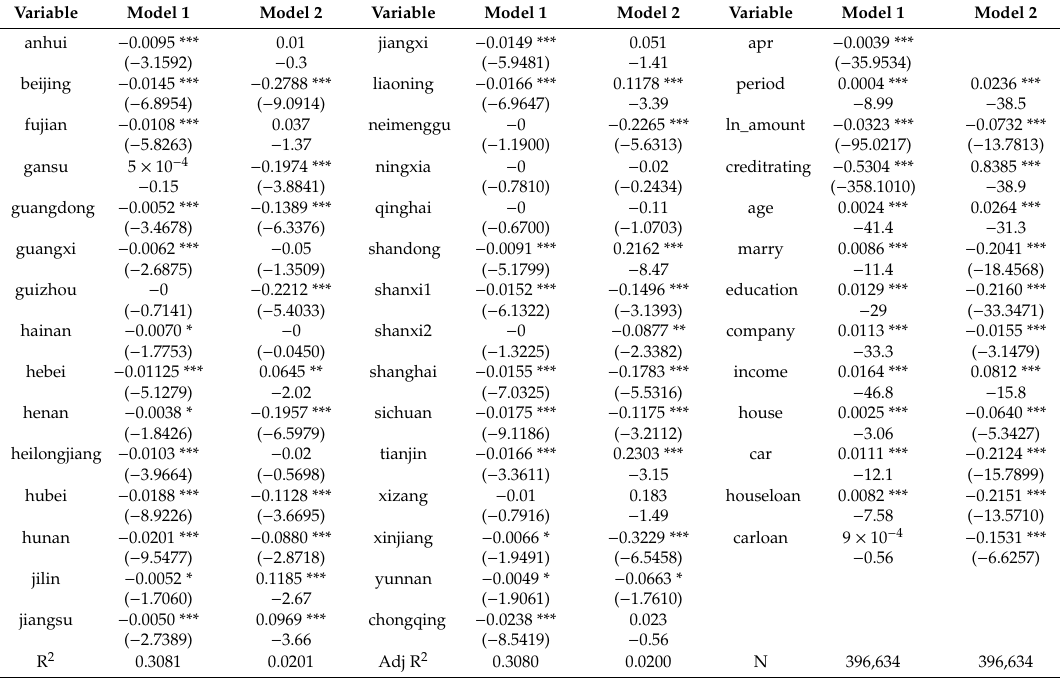
Table 5. Empirical test results of geographical